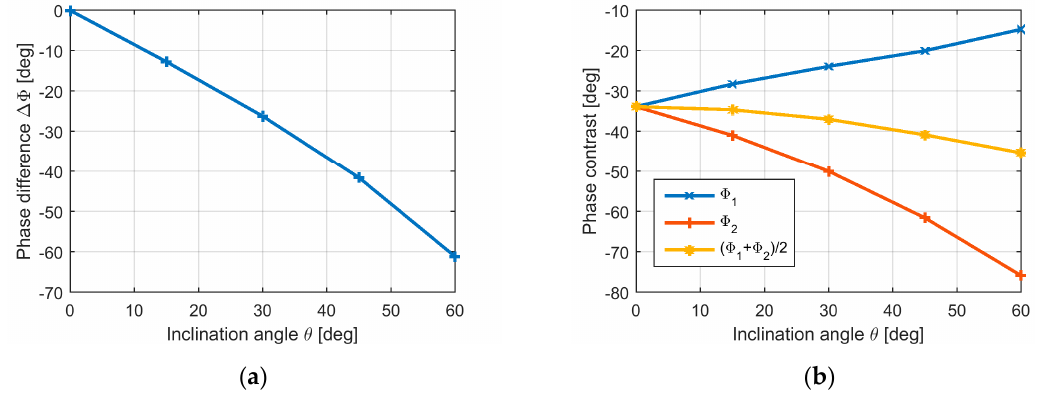
Figure 32. Phase difference ( a ) and phase contrasts ( b ) for an asymmetrical phase distribution depending on the inclination angle of the crack with a 1 mm depth. For the definition of the displayed values see Figure 31a.